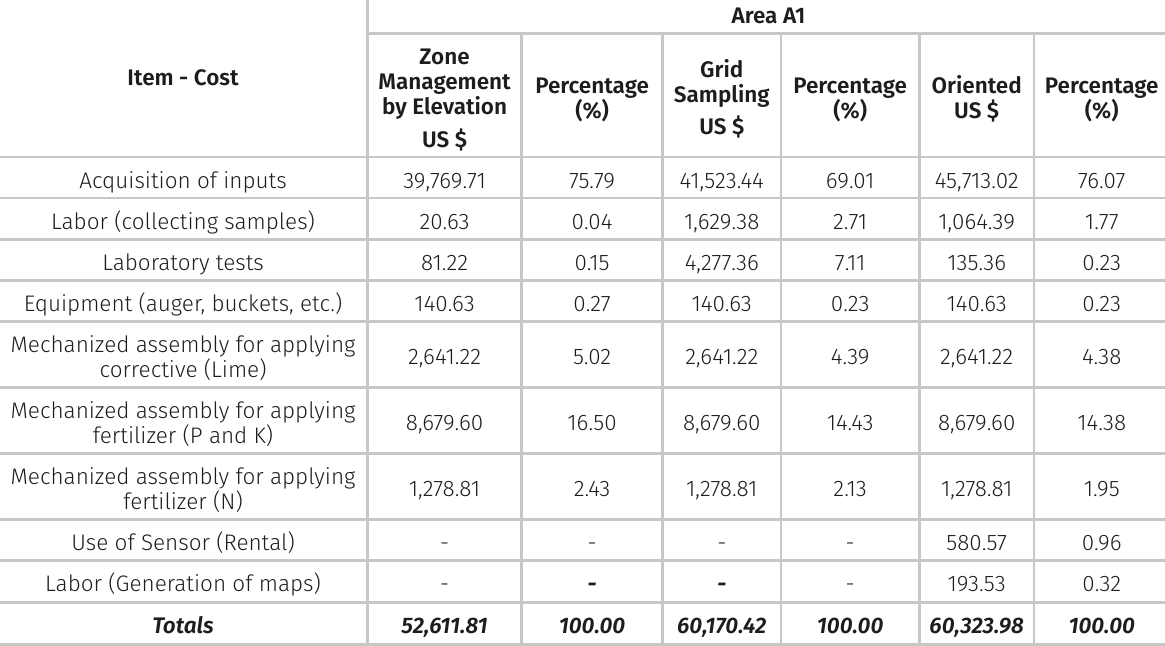
Table V. Acquisition costs of raw materials, labor, laboratory analysis, equipment, machinery, sensor use and generation of maps for area